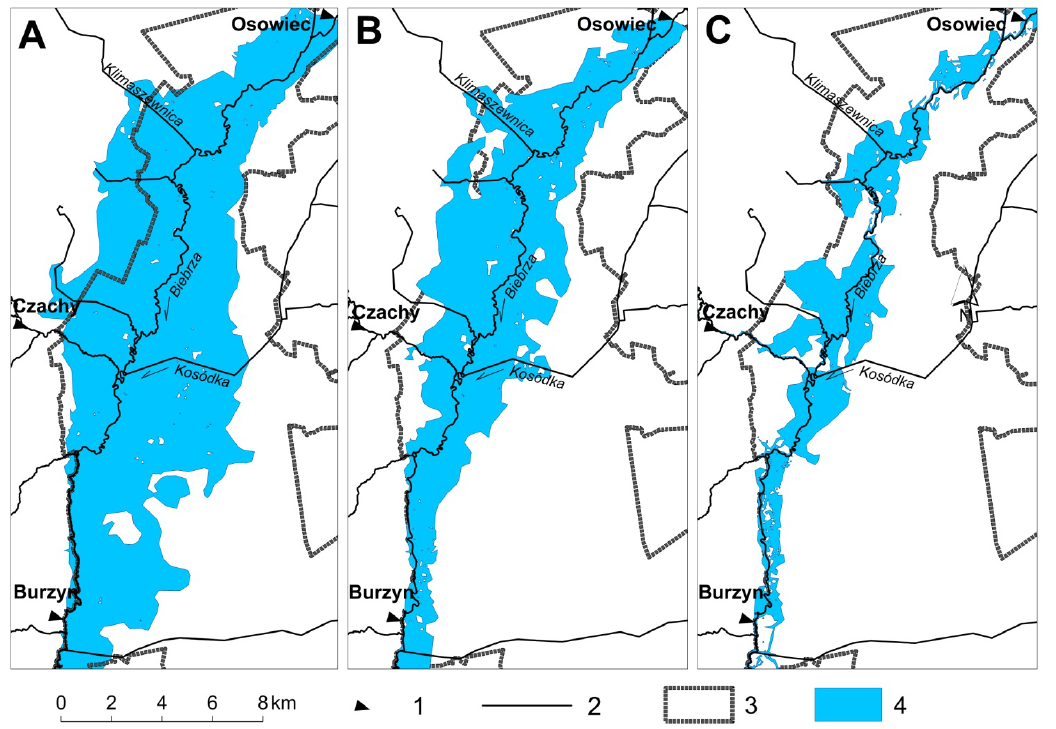
Figure 4. Flood extent delineation in the Lower Biebrza Basin. ( A ) Flood of 1% exceedance probability; ( B ) flood of 50% exceedance frequency; ( C ) flood extent delineated for